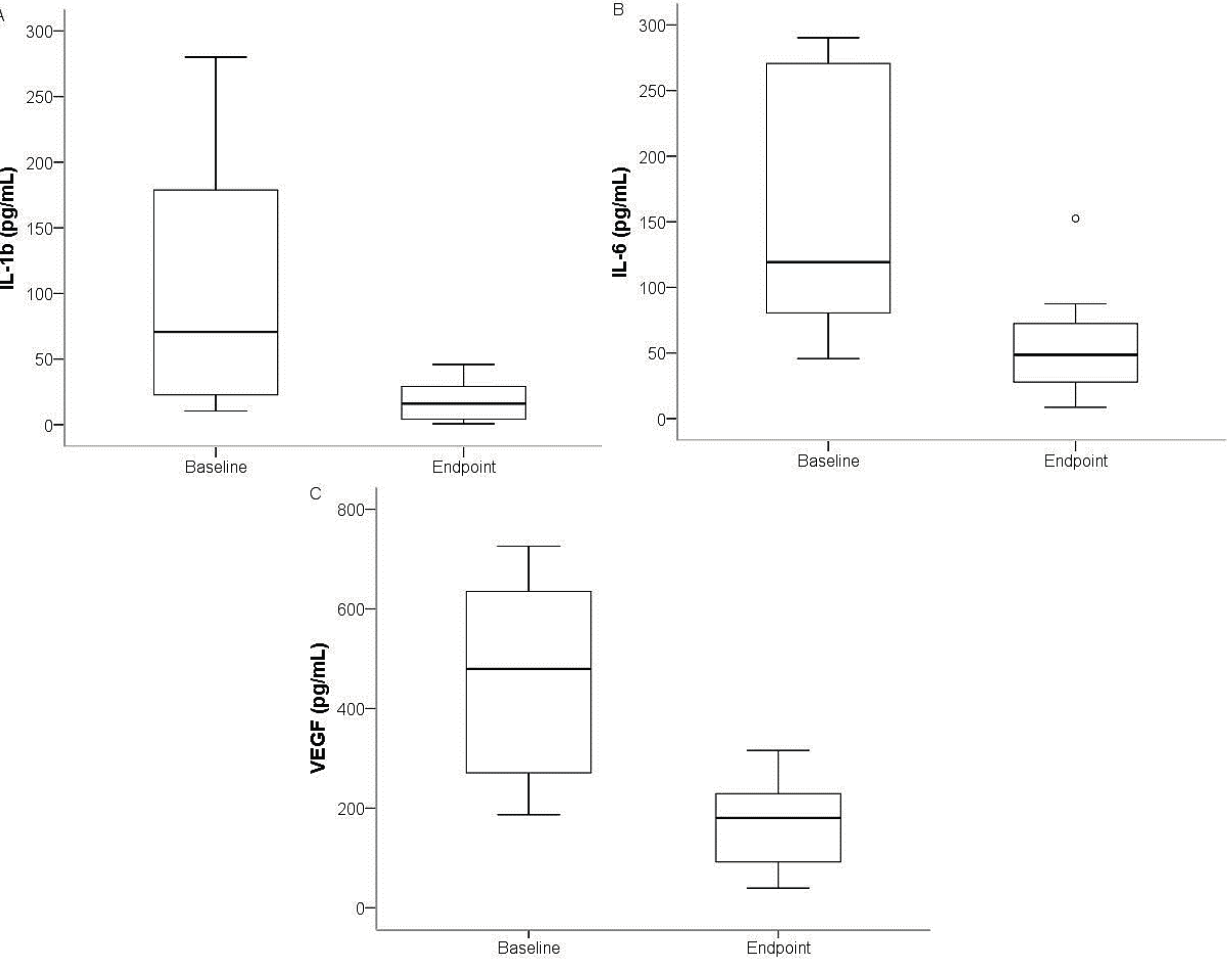
Figure 1. Boxplot diagram (median values, 25th and 75th percentiles, open circle represents outlier value) illustrating gingival crevicular fluid (GCF) changes in IL-1 β ( A ); IL-6 ( B ); and VEGF ( C ) between baseline and at study endpoint in individuals who consumed 500 g bilberries